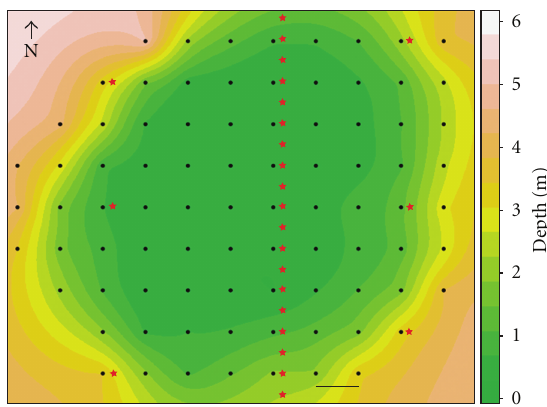
Figure 2: Ordinary kriging interpolation of depth across the reef. Small black dots are the locations of 85 temperature data loggers. Red stars are the locations of rebar placed for orientation. Scale bar in the lower right is 4 meters. Green areas are shallow, and peach ones are